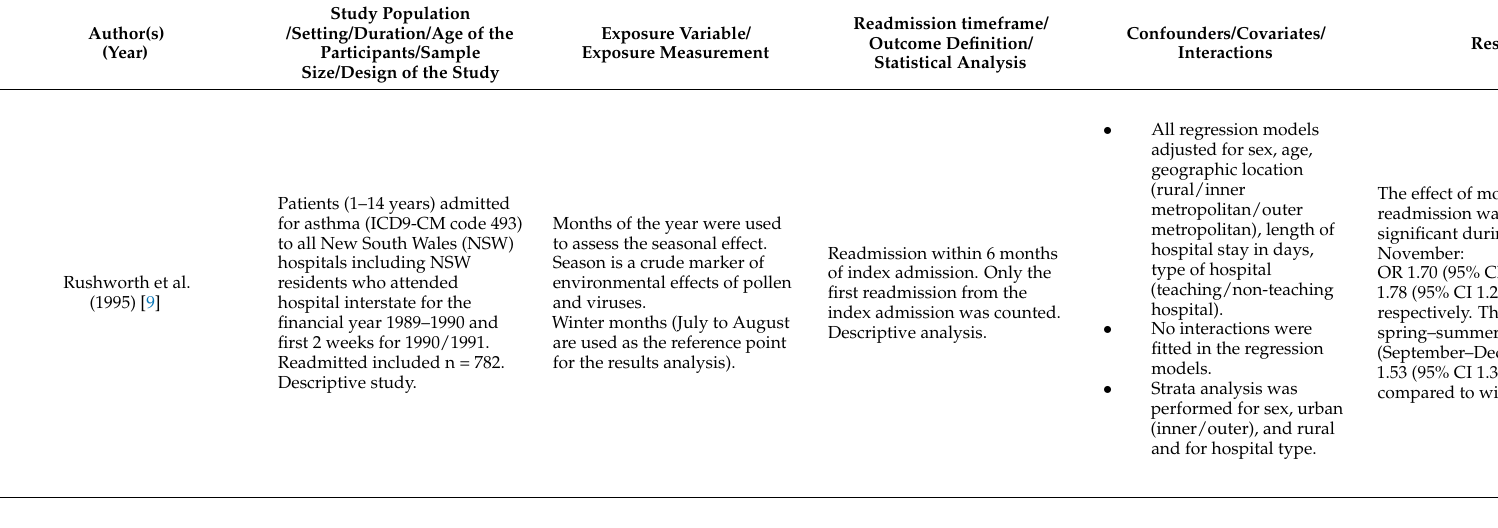
Table 2. The characteristics and findings of included Odds Ratio